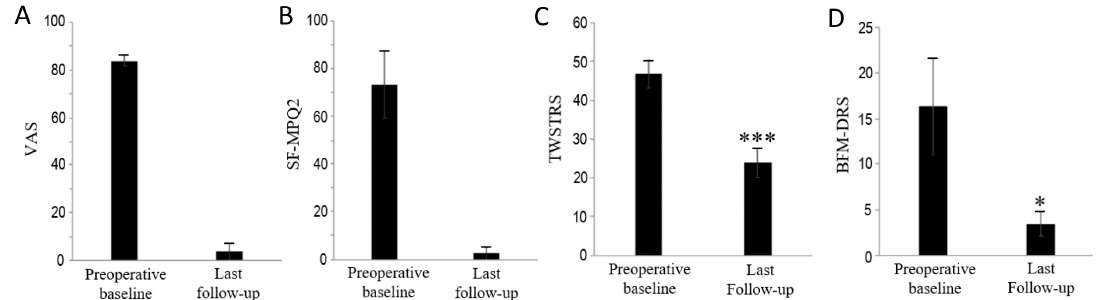
Figure 2. Clinical outcomes of patients with painful cervical dystonia who underwent cervical burst spinal cord stimulation. ( A ) Visual analog scale (VAS), ( B ) Short-Form McGill Pain Questionnaire (SF-MPQ-2), ( C ) Toronto Western Spasmodic Torticollis Rating Scale (TWSTRS), and ( D ) Burke–Fahn–Marsden Dystonia Rating Scale (BFMDRS).